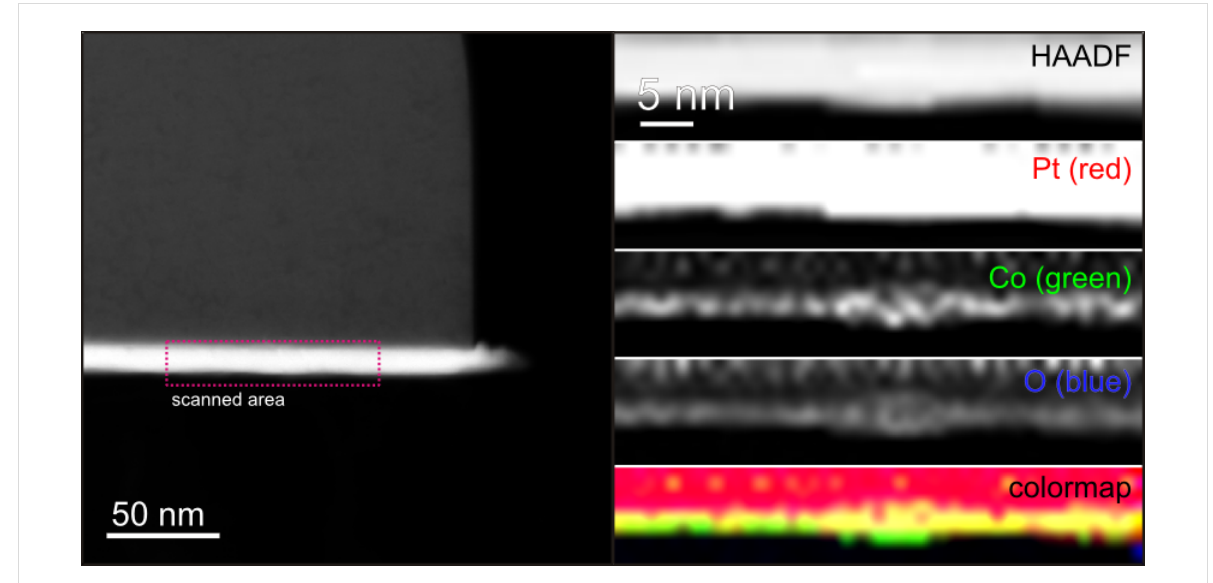
Figure 9: The left image shows the high angle annular dark-field (HAADF) image of the sample shown in Figure 8 using scanning TEM. EDX scan- ning TEM analysis of the selected area is shown on the right for Pt, Co, and O. A color map is reconstructed by using Pt as red color channel, Co as green color channel, and O as blue color channel. The yellow region at the film surface consists of both, Co and Pt and, thus, indicates alloy forma-